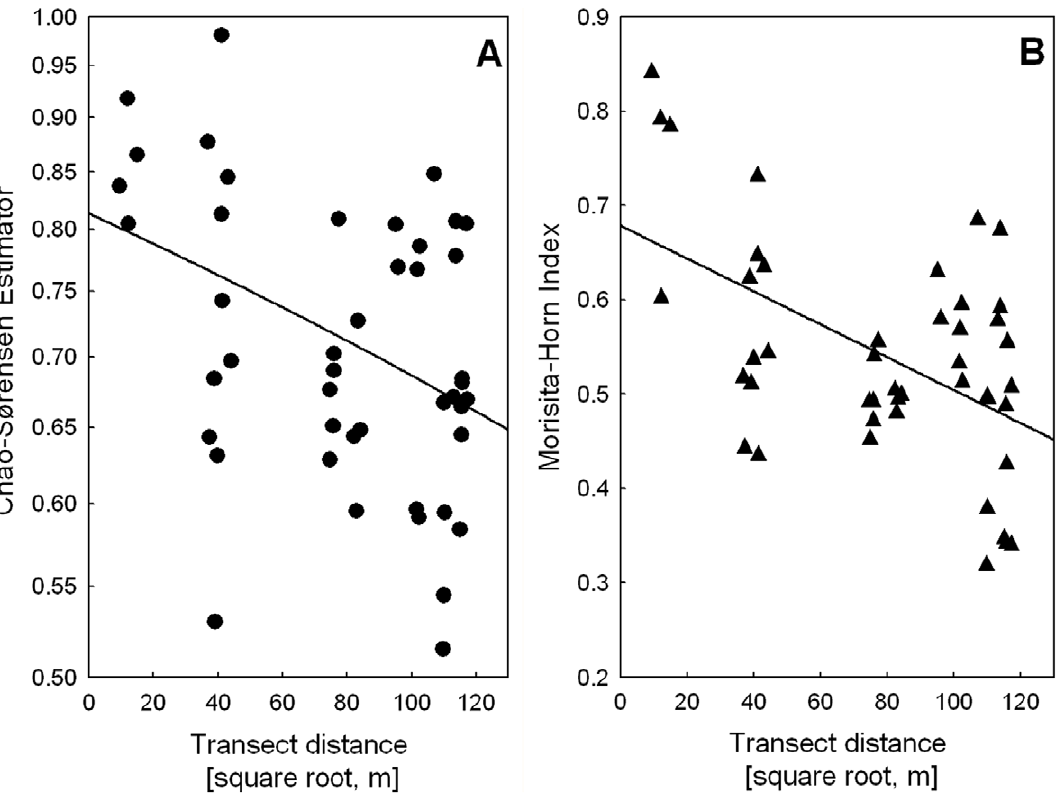
Figure 3. Transect distances and beta diversity measures. Statistic calculations were done with mantel tests on inverted indices, regressions lines are only given for visualization. Mind the different scales of the Y-axes. 3a) Distance decay of transect similarity as shown by Chao-Sørensen estimations (Regression line y=0.8134 2 0.0013*x). 3b) Distance decay of transect similarity as demonstrated by the Morisita-Horn index (Regression line y=0.6785 2 0.0017).